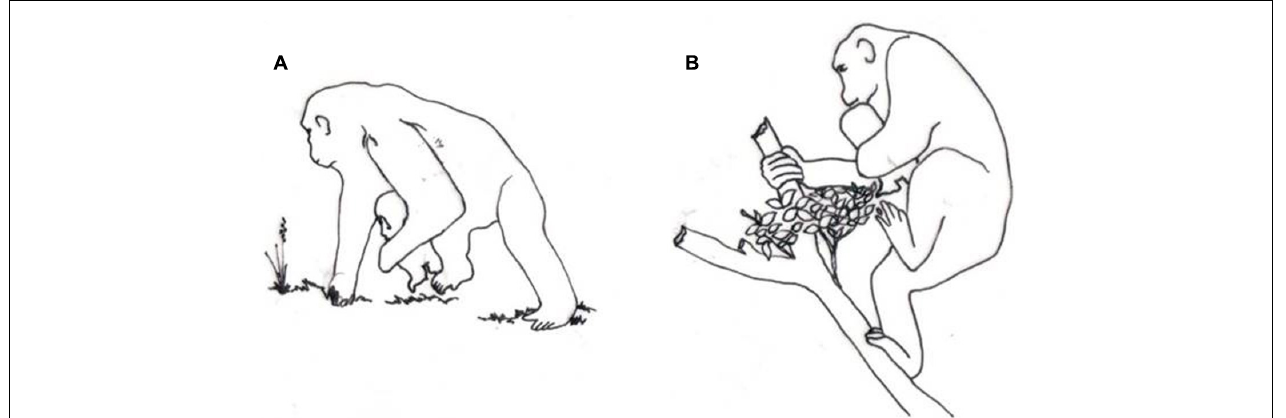
FIGURE 4 | Experimentally obtained stress (Force) strain (relative deformation) curves for single hairs: (A) humans (B) Gorilla (C) Gibbon (D) Orangutan. Typical regions are seen: elastic (E), plastic (P) post yield (PY) and final break. In panel (A) the insert shows the linear region with coefficient α . See text for explanations.